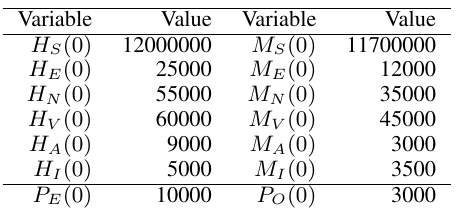
Table II: Numerical values for the initial conditions of model